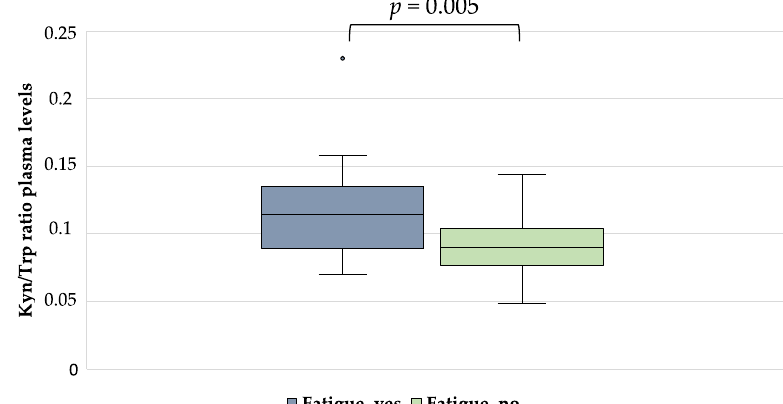
Figure 1. Kyn/Trp ratio in plasma of HD patients with and without